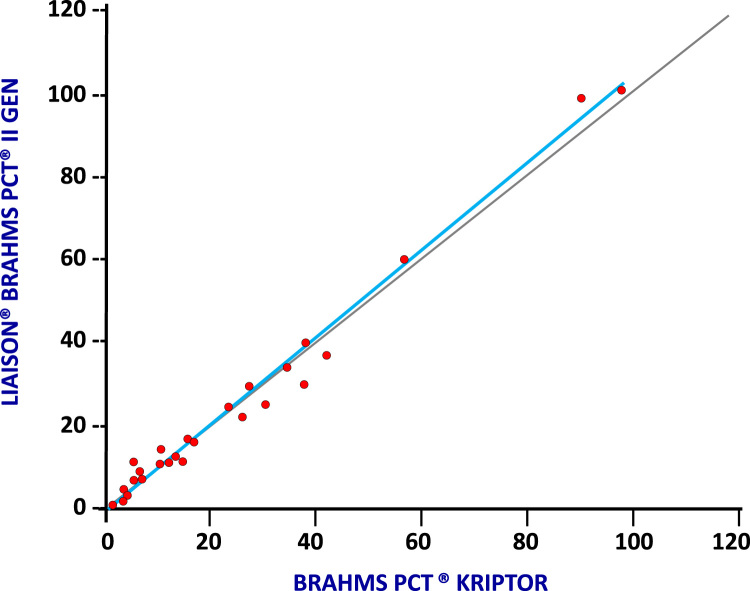
BRAHMS PCT® KRYPTOR vs LIAISON® BRAHMS PCT® II GEN correlation (r=0.99).